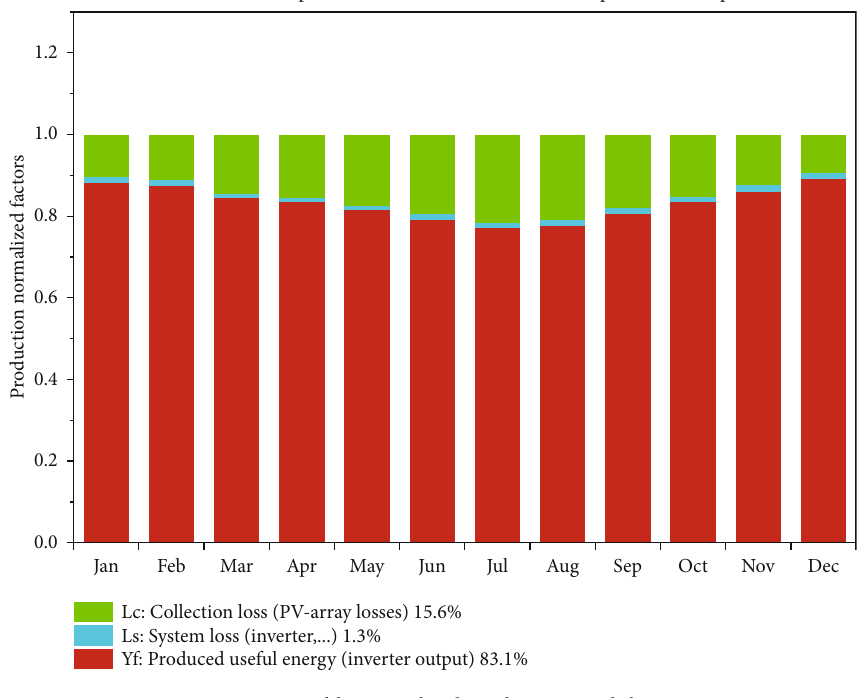
Figure 5: Monthly normalized productions with